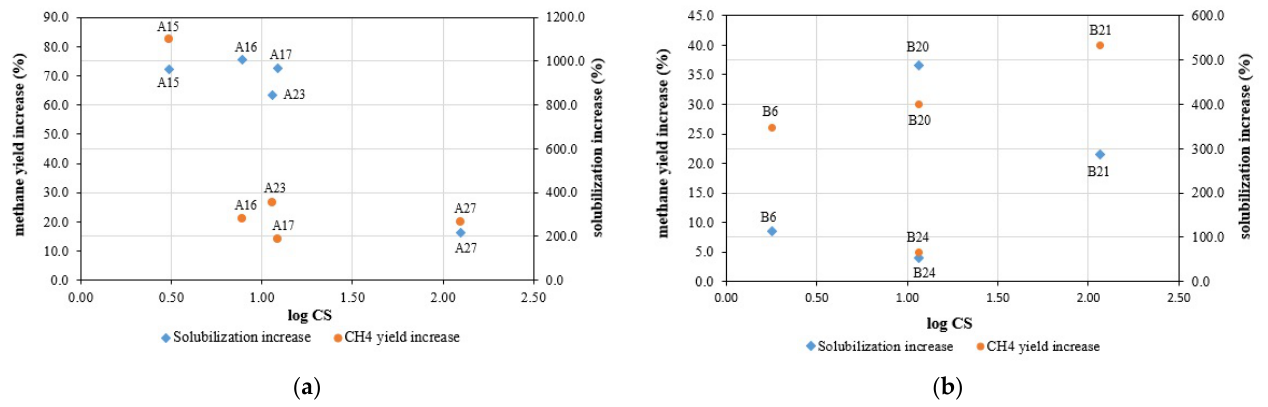
Figure 3. Relationship between the combined severity factor of thermochemical pretreatments with HCl and NaOH, solubilization (S p ), and methane yield (Y p ). ( a ) Thermochemical pretreatment with acid (HCl). ( b ) Thermochemical pretreatment with alkali (NaOH).